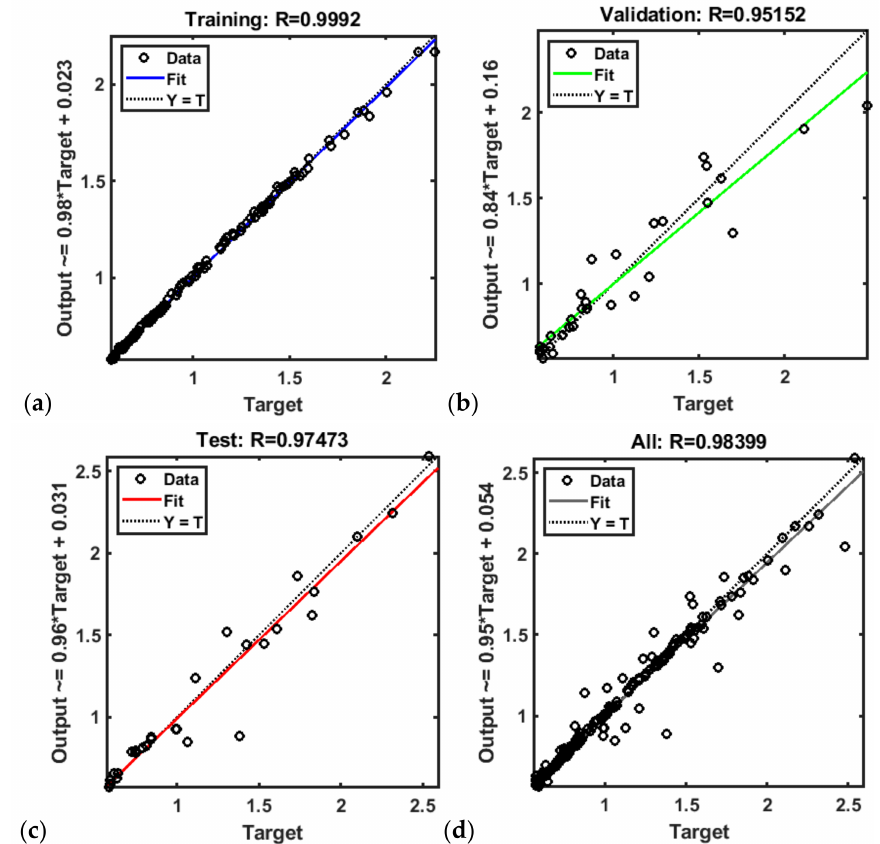
Figure 13. Regression diagrams for the ANN trained by applying Levenberg–Marquardt algorithm calculated for ( a ) training dataset ( b ) validation dataset ( c ) dataset used for testing and ( d ) dataset with all three aforementioned groups of